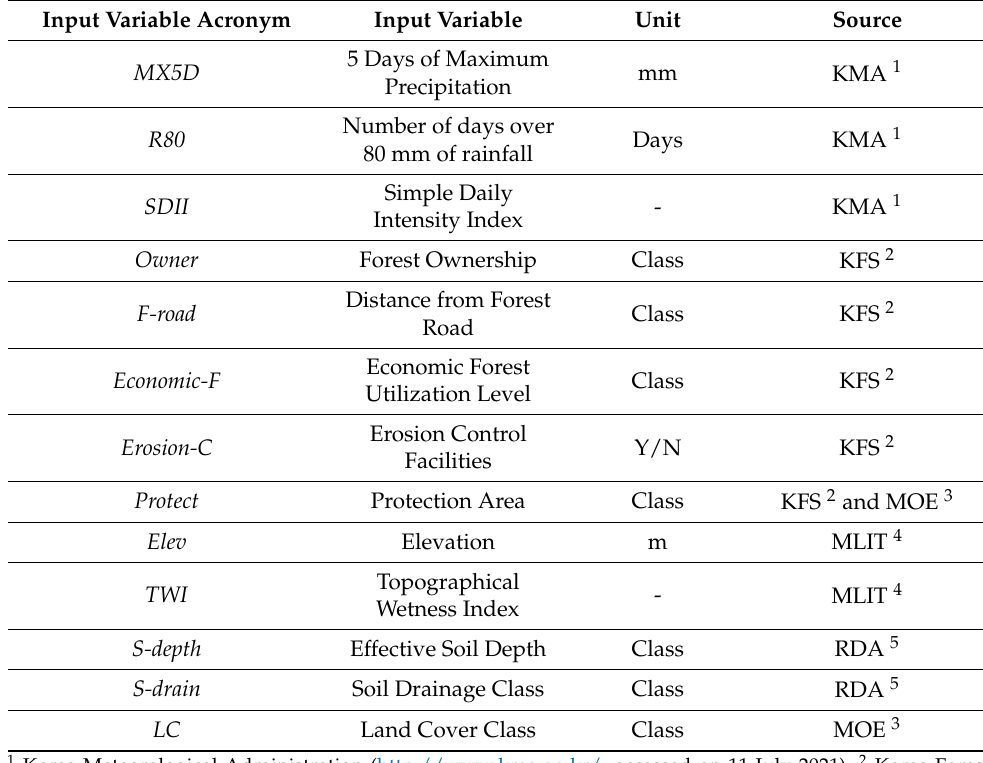
Table 1. Input variables used to assess landslide